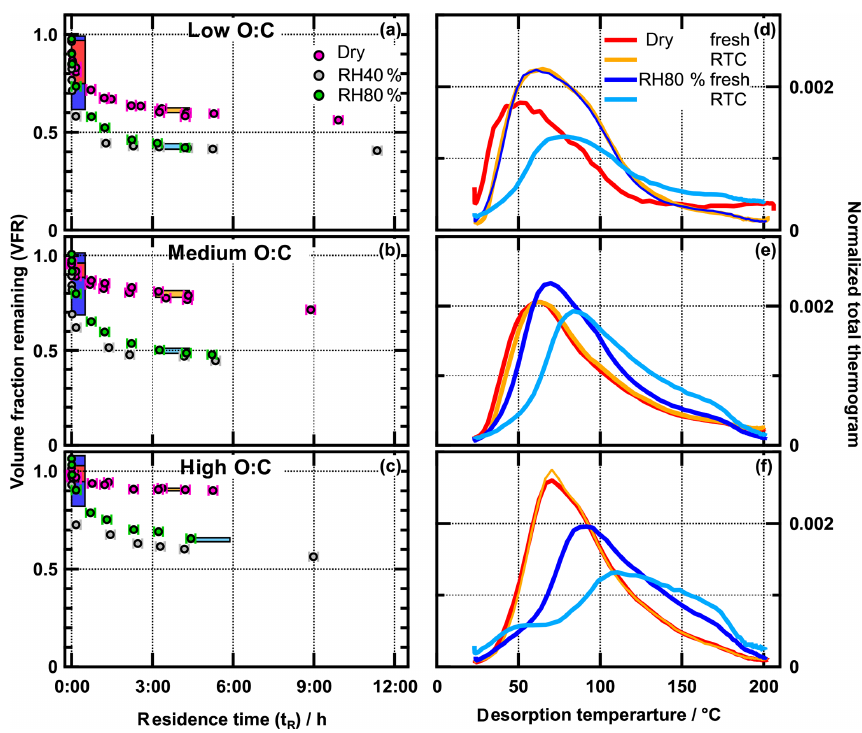
Figure 1. Evapograms (a–c) and total thermograms (d–f) for low O : C (a, d) , medium O : C (b, e ), and high O : C (c, f) . Coloured boxes in evapograms indicate FIGAERO sampling time. Thermograms are normalized with total signal area.